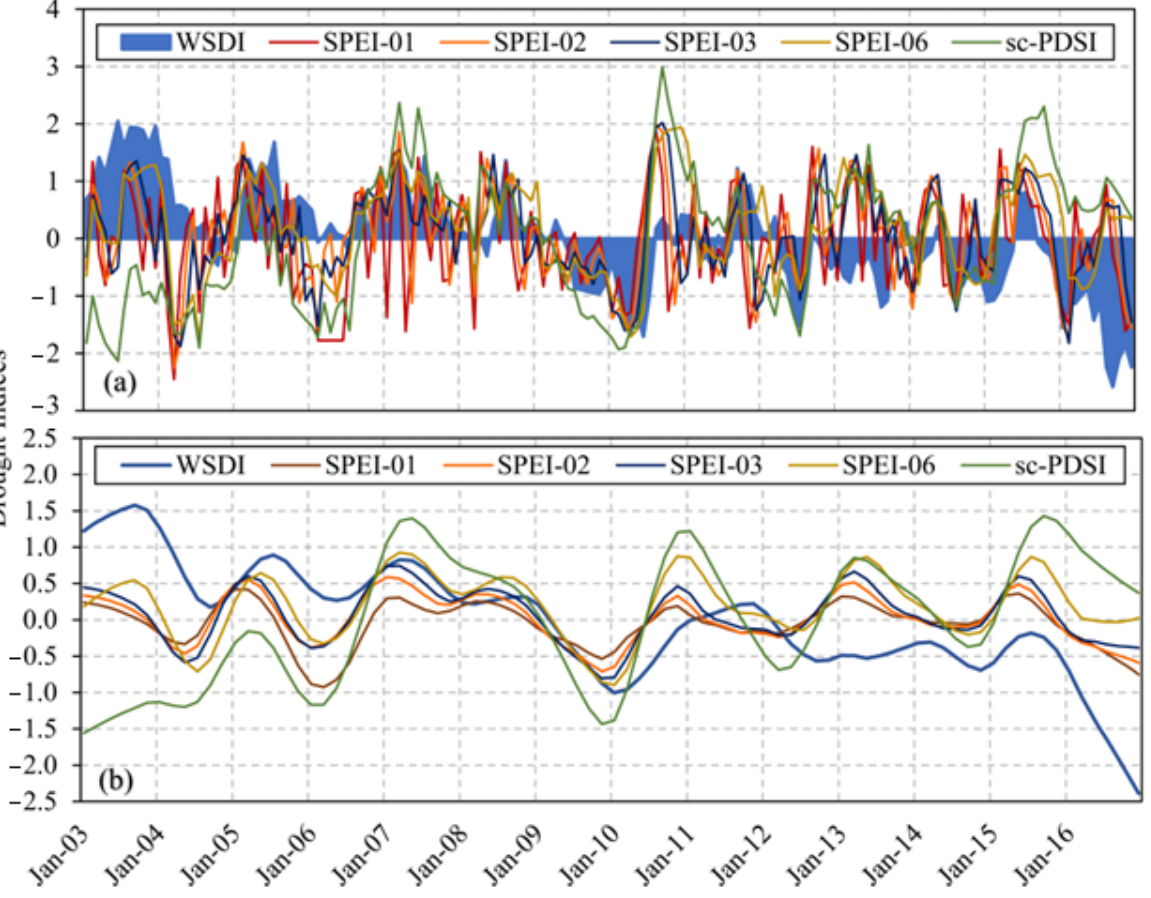
Figure 9. ( a ) WSDI comparisons with other drought indices and ( b ) STL decomposed inter-annual trends for the IBIS.